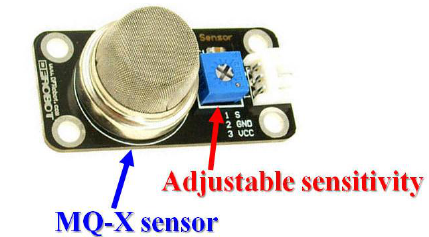
Figure 24. Analog gas quality sensor.